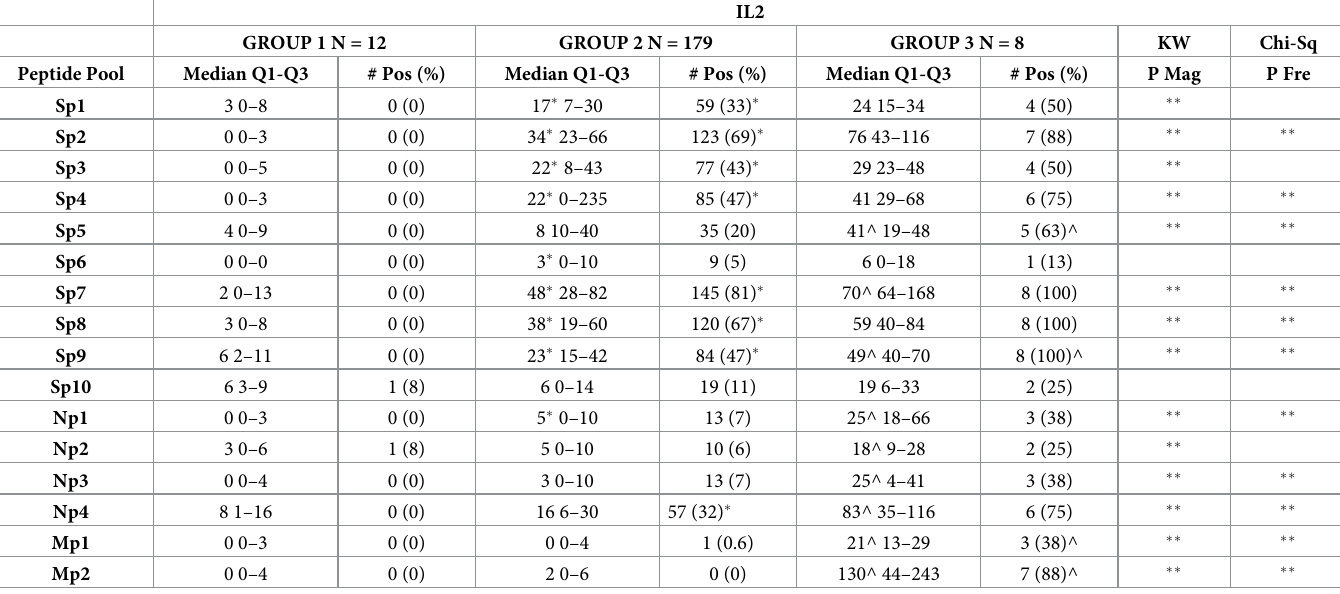
Table 3. FluoroSpot IL2 responses to individual S, N, and M peptide